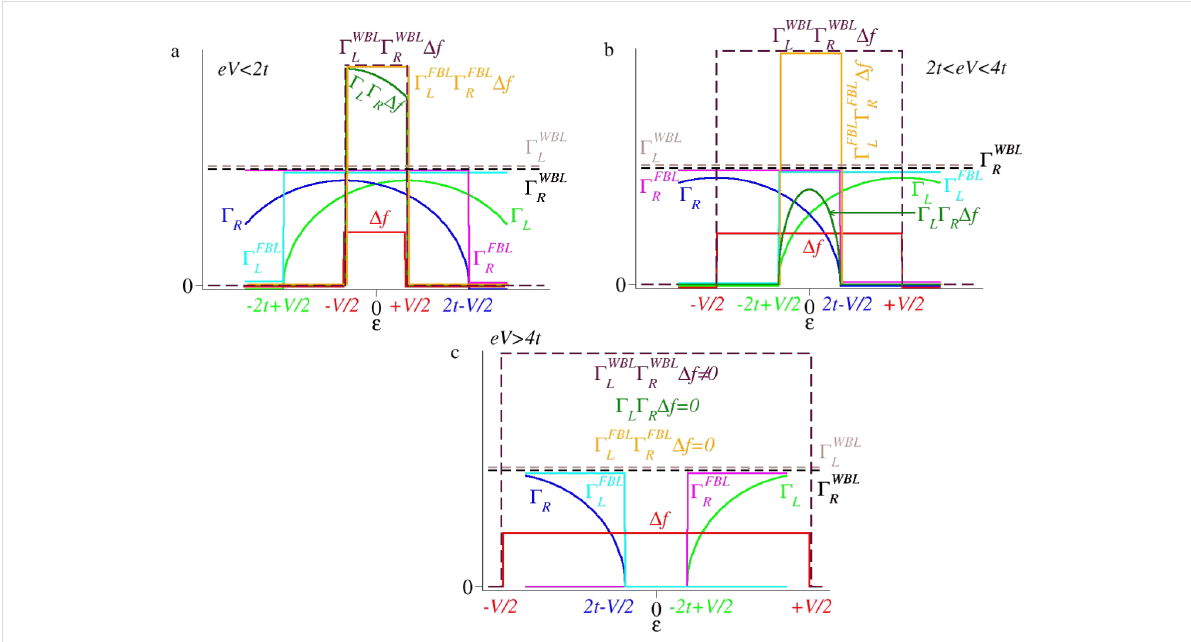
Figure 4: Schematic representation of the exact and approximate quantities entering the expression for the current in Equation 7 in the relevant bias ranges (0 < eV < 4 t ). Γ L,R are width functions computed exactly (no label) and within the wide-band and flat-band limits (labels WBL and FBL, respec- tively). Δ f ≡ f L − f R represents the difference between Fermi distributions of the left and right electrode. (a) At biases eV < 2 t , the exact and approxi- mate width functions behave similar (all are nonvanishing in the Fermi energy window − eV /2 < ε < eV /2 of allowed transitions), and this yields currents computed exactly and approximately, behaving qualitatively similar (cf. Figure 2). (b) The values for 2 t < eV < 4 t , Γ L,R , computed exactly and within the flat-band approximation, have nonvanishing values in an energy range narrower than the Fermi window, which becomes narrower as the bias in- creases. Therefore, the flat-band approximation can qualitatively predict an NDR effect. Still, because of substantial quantitative differences from the exact values, the FBL-estimated current is quantitatively unsatisfactory. (c) For eV > 4 t , the energy ranges wherein Γ L and Γ R (computed exactly and within the FBL) have nonvanishing values that do not overlap. This yields vanishing currents, unlike within the WBL, which nonphysically predicts nonvanishing